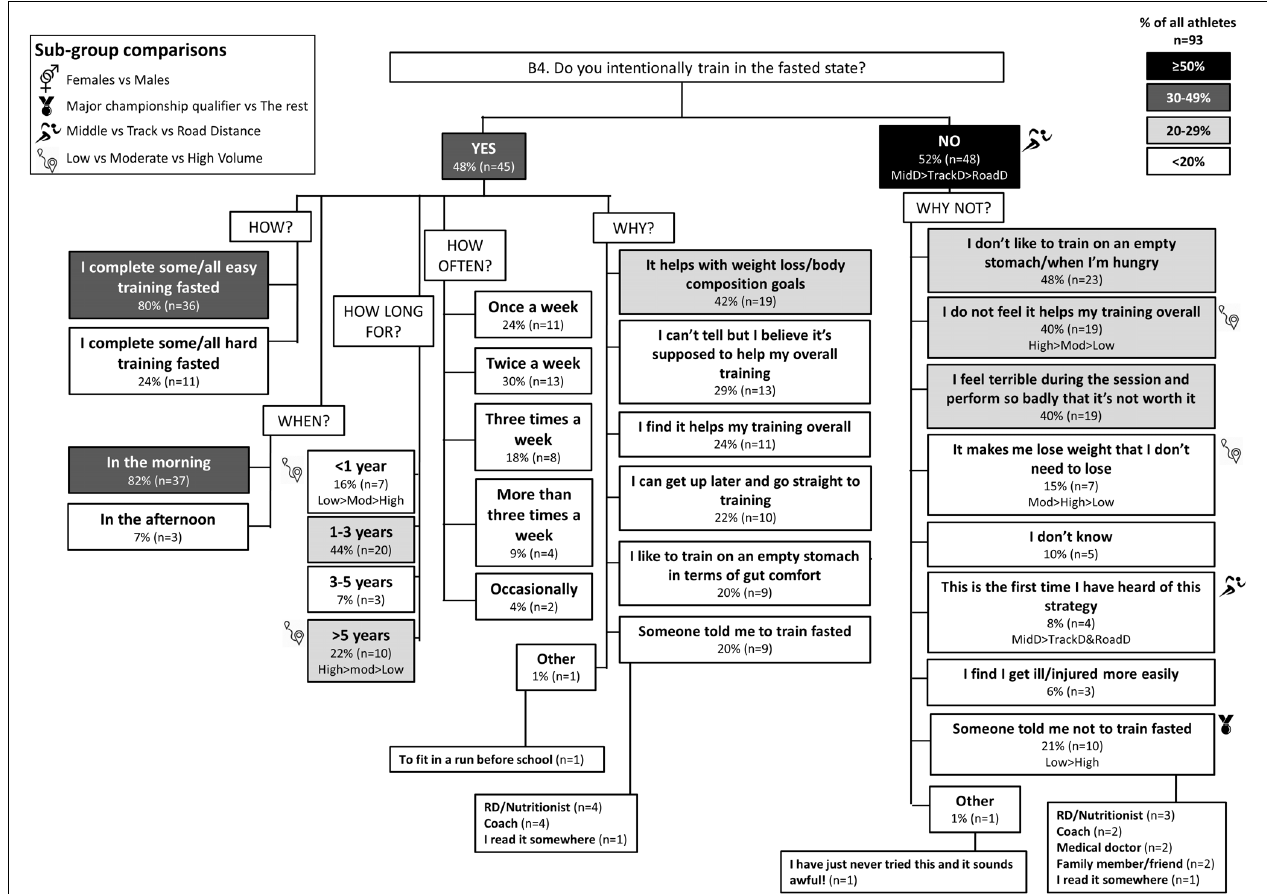
FIGURE 5 | B4: Fasted training during base training phase. The prevalence of training in the fasted state with specific details around timing, frequency and reasons for this strategy in 93 elite female and male track and field endurance athletes. Please see full description for figure within Figure 1